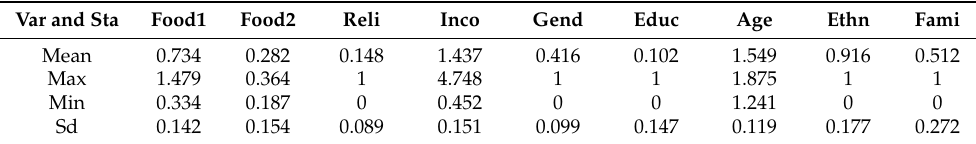
Table 2. Results of basic statistical